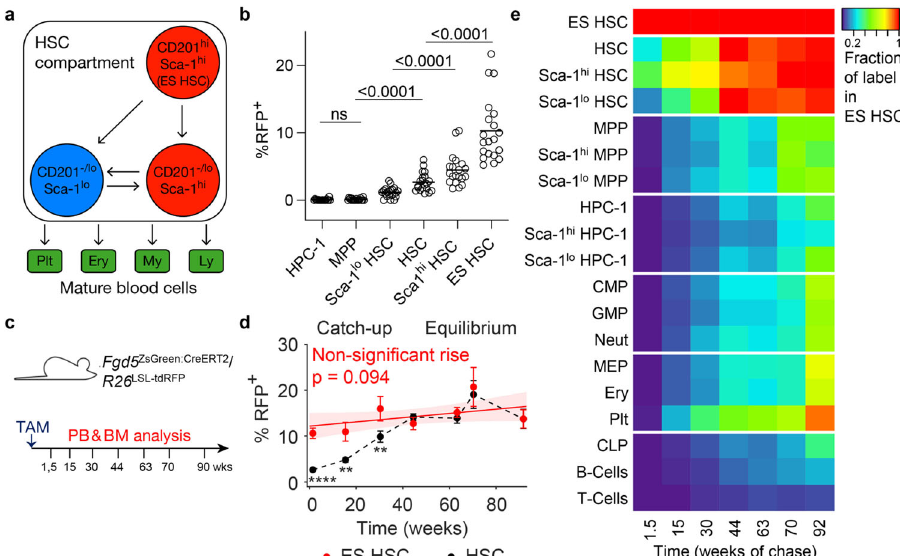
Fig. 1 Fate mapping of CD201 hi Sca-1 hi HSCs. a Subdivision of the immuno-phenotypic HSC population (LSK CD48 − /lo CD150 + ) by CD201 (EPCR) and Sca-1 expression; ES-HSC, CD201 (EPCR) hi Sca-1 hi HSCs. Relations between HSC populations in native hematopoiesis and how they connect to